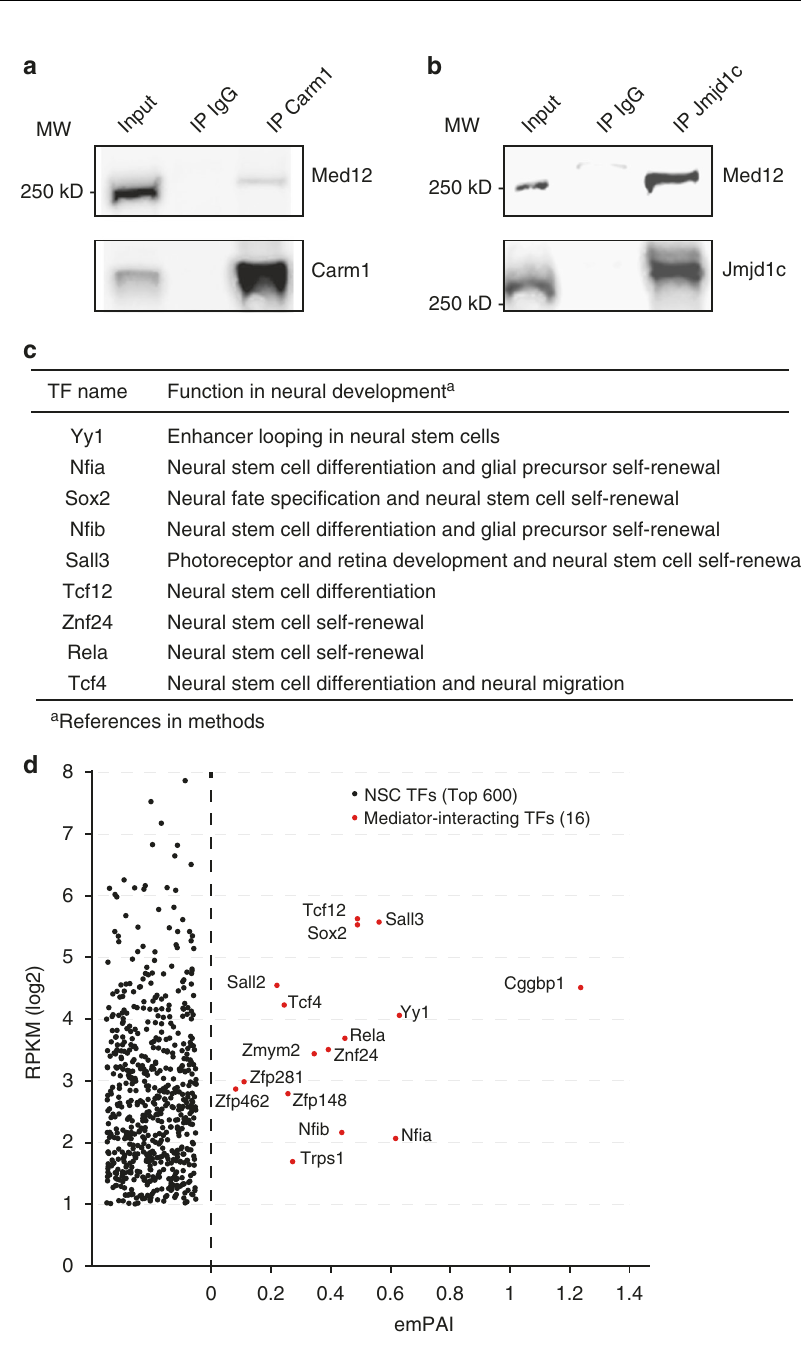
Fig. 2 Mediator complex interactor validation. a Immunoprecipitation (IP) of Carm1 and Med12 by a Carm1 antibody from NSC nuclear extract. Western blots are probed with the indicated antibodies. Control IP by rabbit IgG and 5% input are also shown. Source data are provided as a Source Data fi le. b Immunoprecipitation (IP) of Jmjd1c and Med12 by Jmjd1c antibody from NSC nuclear extract. Western blots are probed with the indicated antibodies. Control IP by rabbit IgG and 5% input are also shown. Source data are provided as a Source Data fi le. c Function in neural development of identi fi ed Mediator-interacting transcription factors in NSCs. References are provided in the Methods. d mRNA levels in NSCs of Mediator-interacting transcription factors (TFs) and the Top 600 highest expressed TFs in NSCs. The average emPAI scores, a semi-quantitative mass spectrometry-based measure of molar amounts, in the four Mediator complex puri fi cations is shown for Mediator – interacting